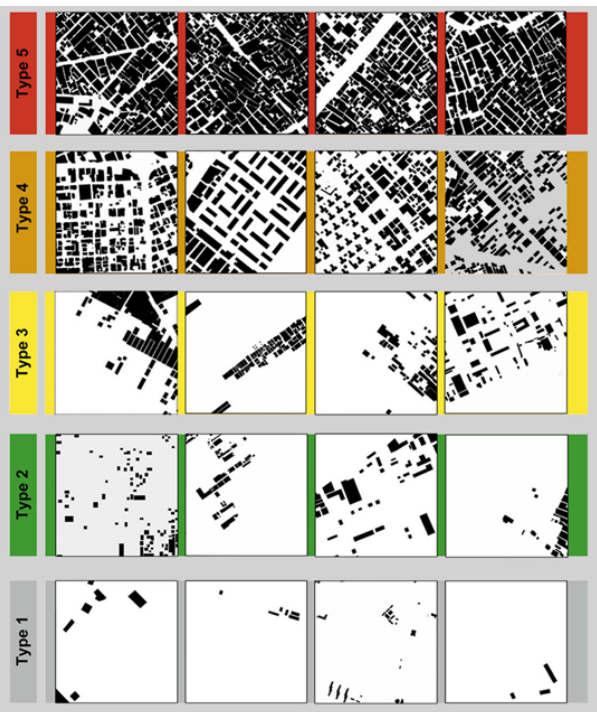
Figure 4: Types of Urban Growth Patterns - Source: Gaudiano 2005 By referring to the fractal analysis of the Eastern part of Metropolitan Alexandria of years 1959, 1985 and 2014 applied by (Hasan, 2012), shows five different types of urban growth patterns: Ranging from the cells that have high fractal dimensions (type 4 and 5), representing the most compact, homogenous patterns and uniform distribution of built-up masses, and found generally in the middle and eastern districts; to the cells that have lower fractal dimensions (types 2 and 3), representing non uniform distribution of urban patterns and contrasting lacuna sizes as represented in the emerging peri-urban informal expansions.